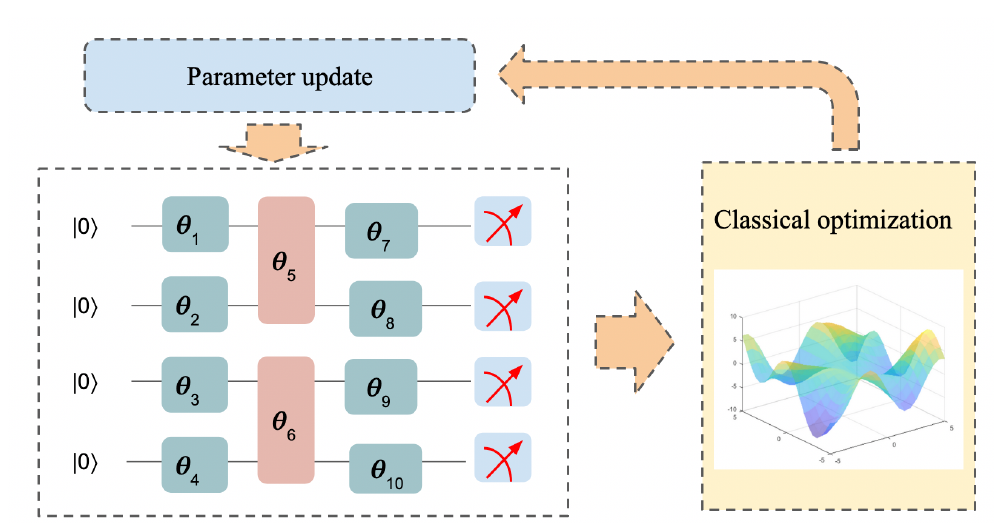
Figure 4. Schematic of variational quantum algorithms as a hybrid architecture leveraging quantum parameterized circuits (PQC) and classical optimization. A specific PQC can be trained over the circuit parameters via classical optimization for a specific problem and cost function; the optimized values then get fed back into the circuit and the procedure repeats iteratively until the desired accuracy is